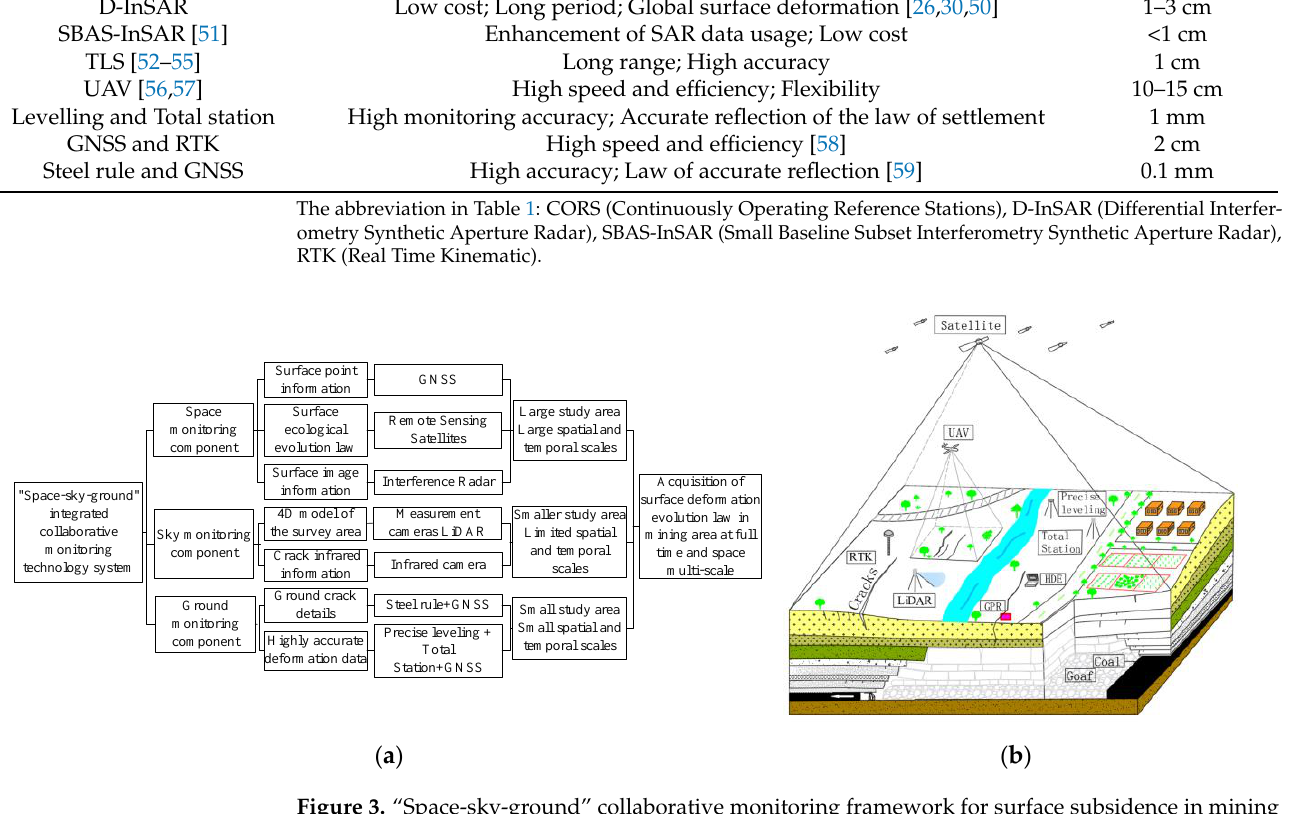
Figure 3. "Space-sky-ground" collaborative monitoring framework for surface subsidence in mining Figure 3. “Space-sky-ground” collaborative monitoring framework for surface subsidence in mining area: ( a ) the content of “ Space-sky-ground ” collaborative monitoring framework; ( b ) the diagram of area: ( a ) the content of “Space-sky-ground” collaborative monitoring framework; ( b ) the diagram of “ Space-sky-ground ” monitoring framework. “Space-sky-ground” monitoring